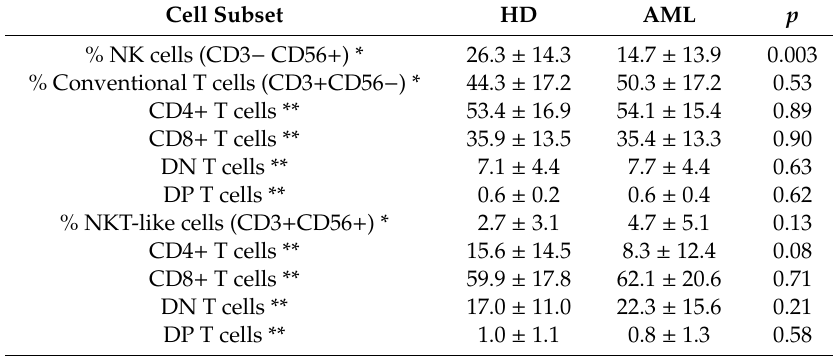
Table 1. Percentage of NK cells and T cell subsets in healthy donors (HD) and acute myeloid leukemia (AML) patients.